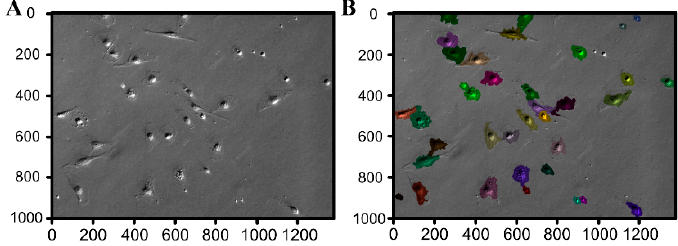
Figure 11. The outcome of the Feineigle-based method for an image ( A ) (40× magnifica-tion). In the resulting image ( B ), colors mark separate regions created by the watershed seg-mentation algorithm.